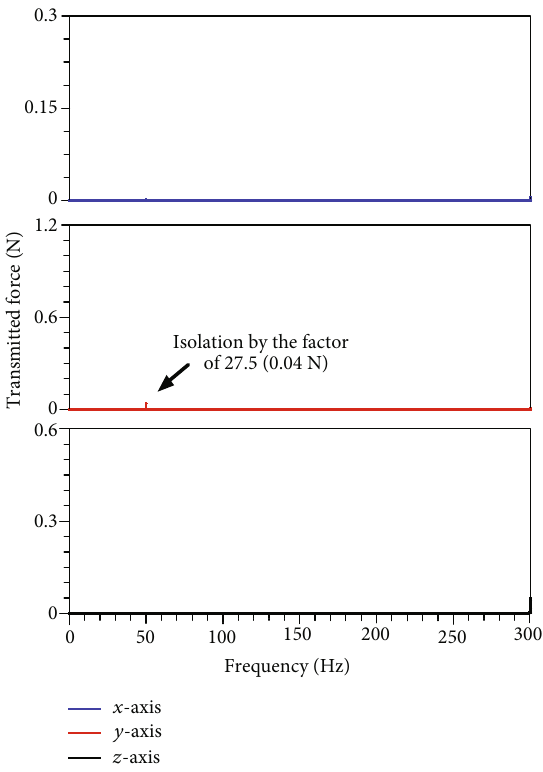
Figure 13: Microvibration measurement test results under 0 g condition.